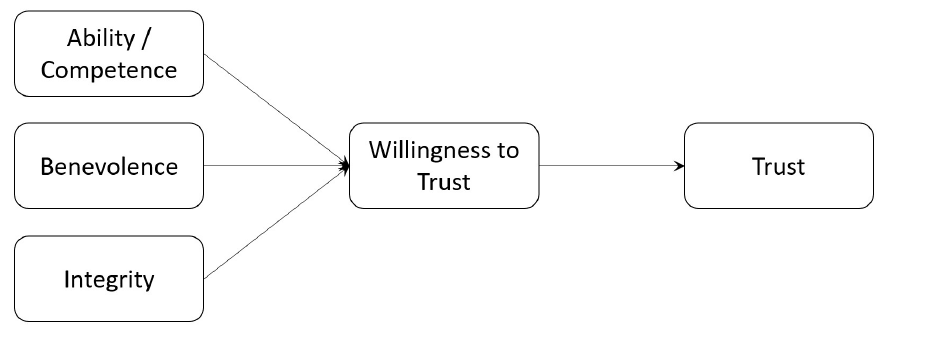
Figure 3. A Schematic Representation of Trust